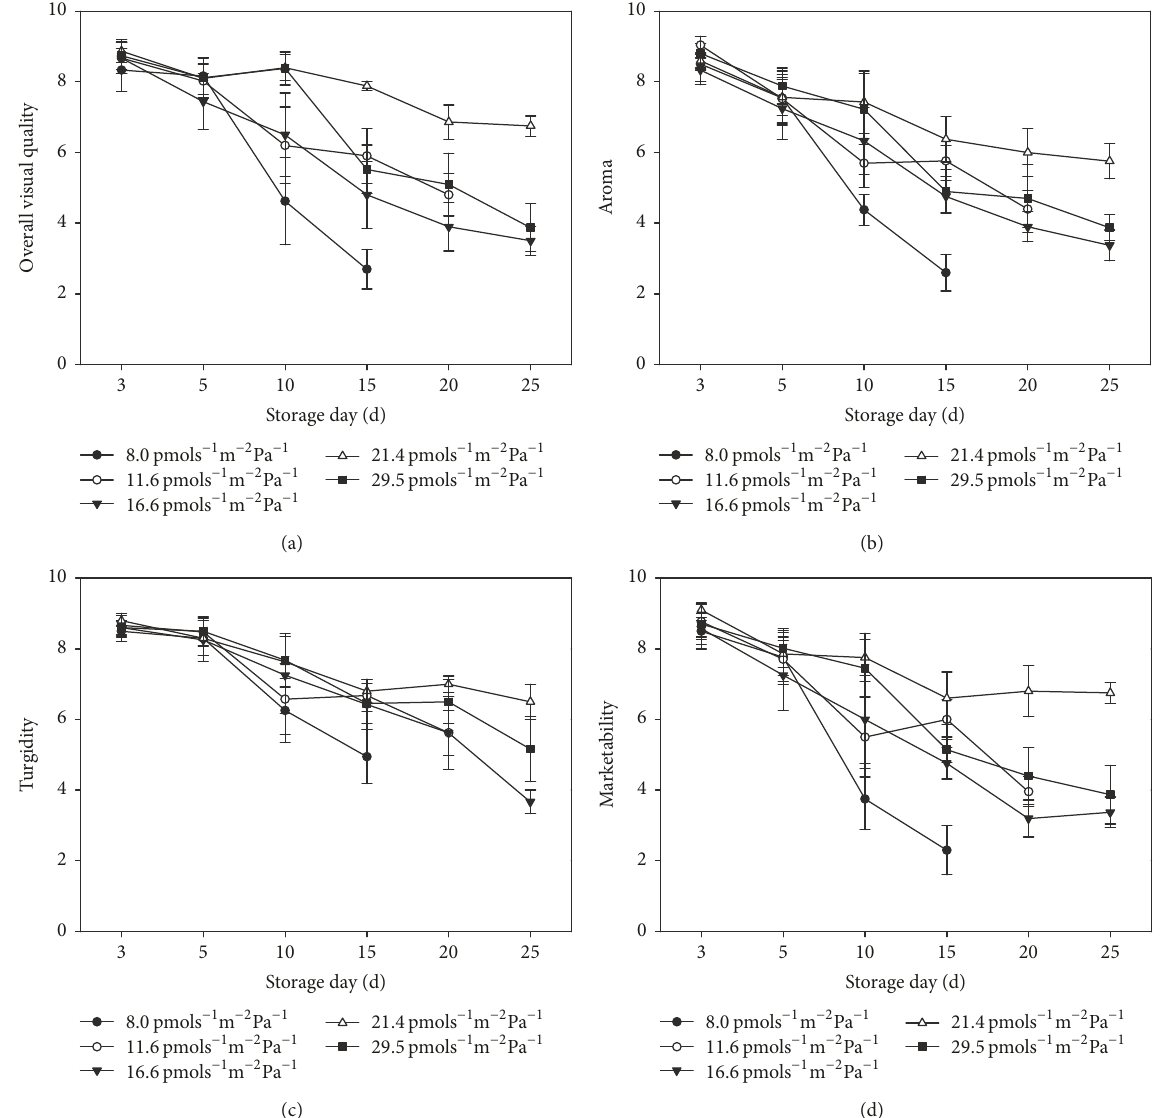
Figure 4: Sensory evaluation of Chinese toon tender shoots during storage at 4 ∘ C in packages with different OTR. Data points represent the mean ± SE ( 𝑛 = 5